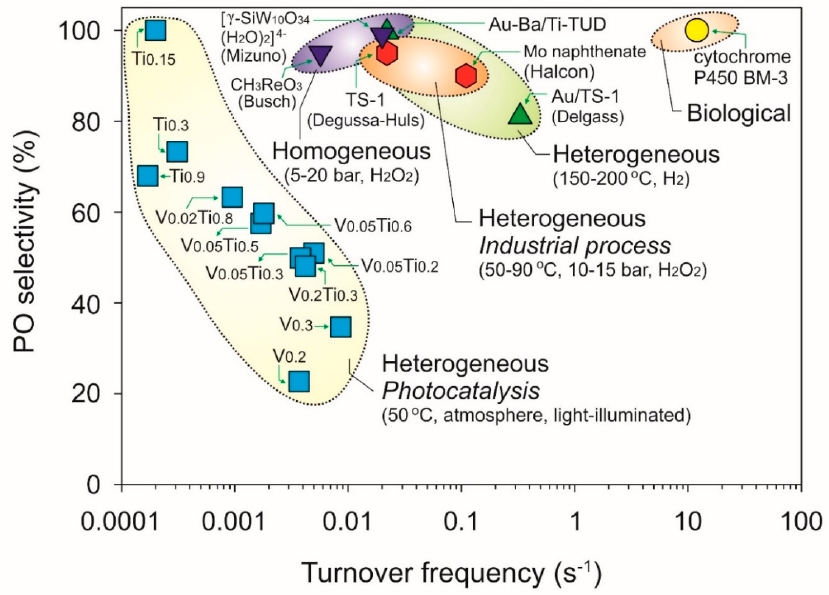
Figure 11. The correlation of turnover frequency versus selectivity for di ff erent propylene epoxidation processes. Reproduced with permission from